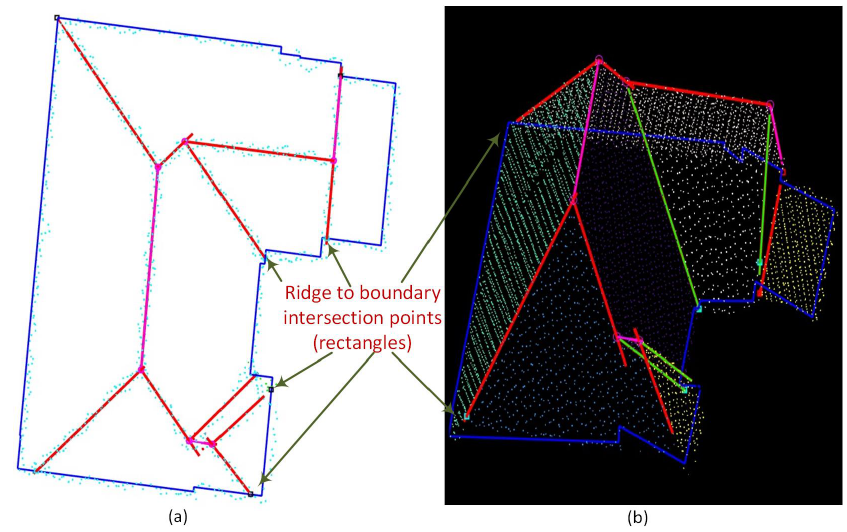
Figure 5. Determination of edge intersection points: ( a ) edge points (ridge to building boundary intersection points); and ( b ) 3-D view of building showing edge